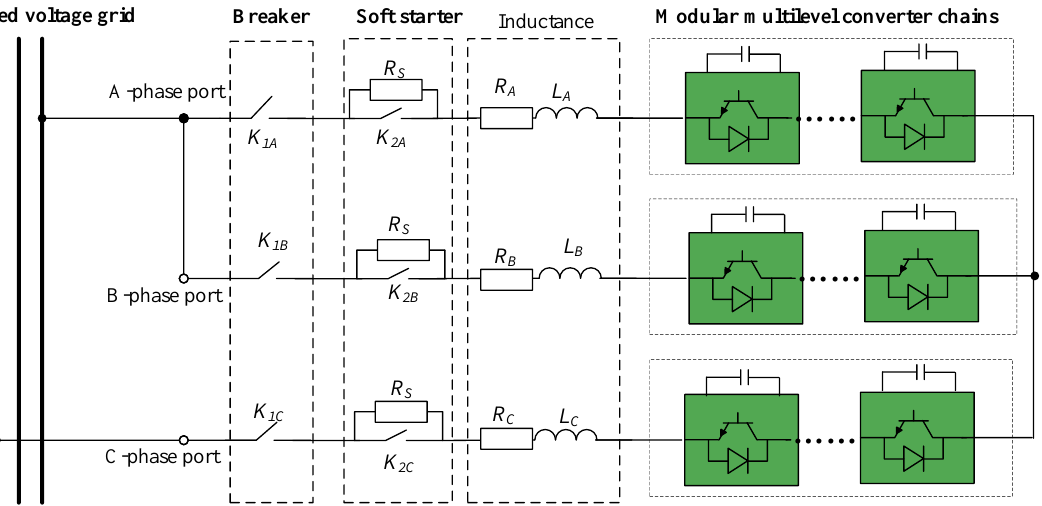
Figure 1. Circuit configuration of the proposed STATCOM testing method.